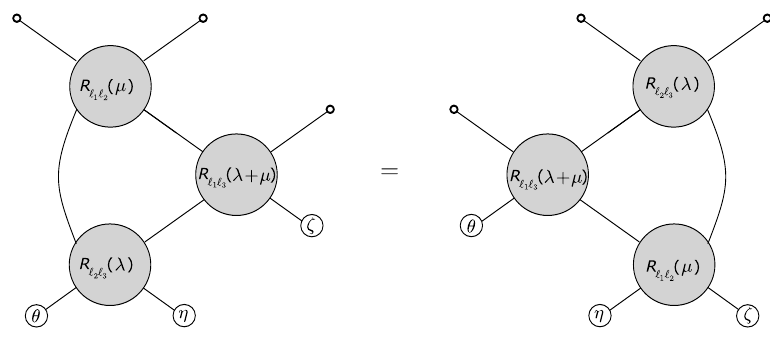
Figure 8 . Property (2.63) in the notation for the fused R l